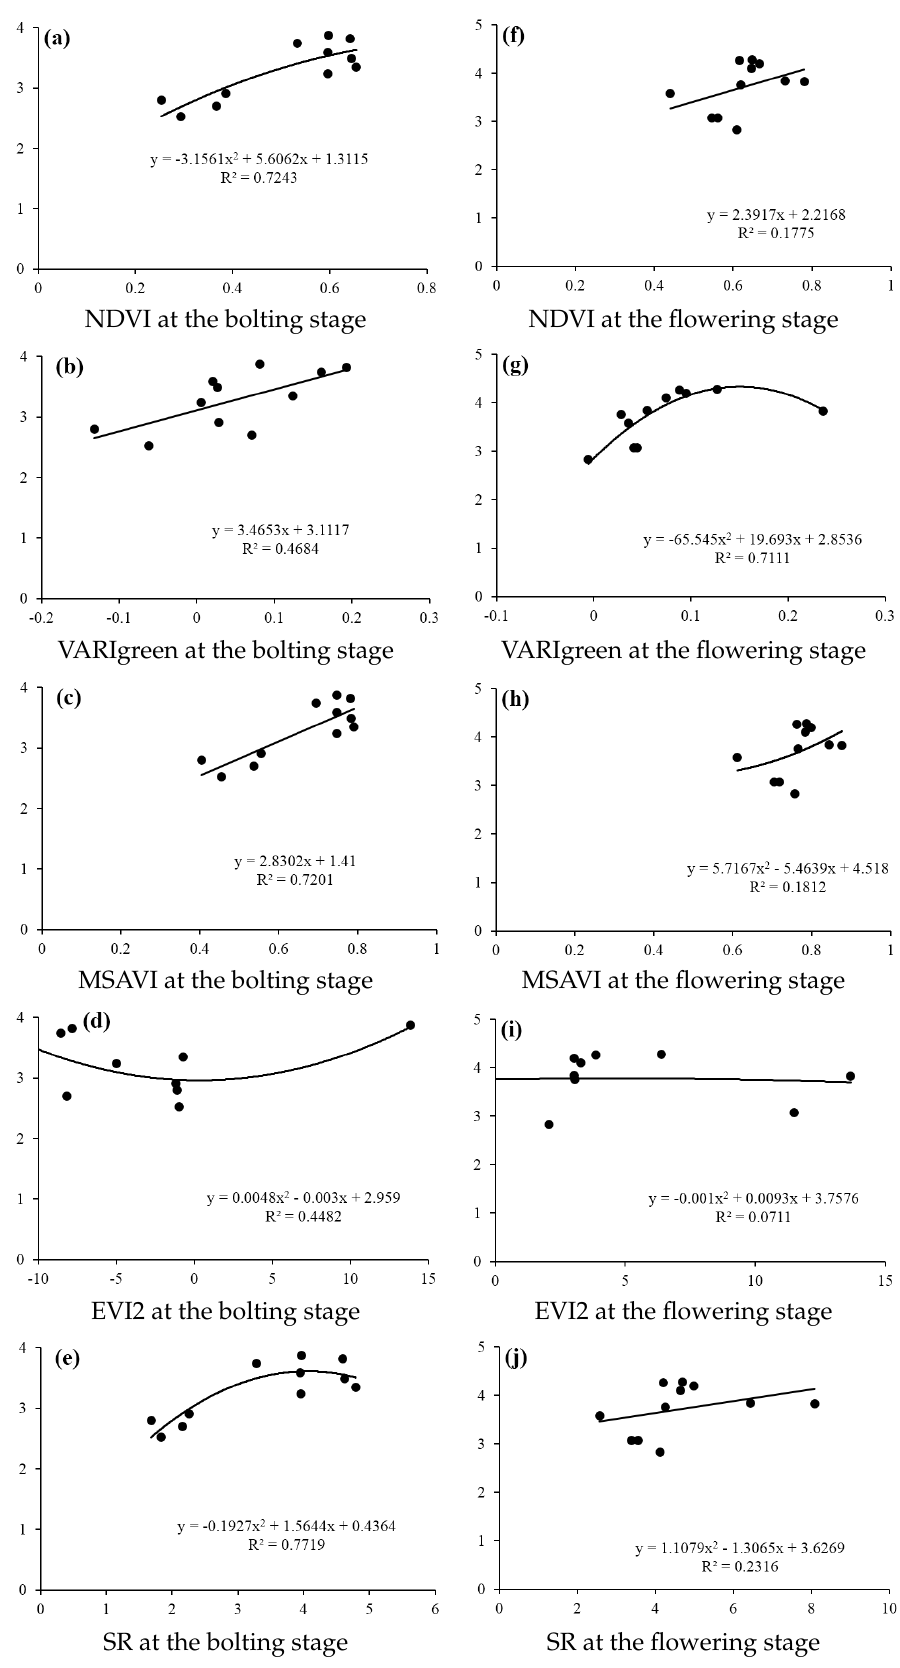
Figure 5. Relationship between ground LAI and vegetable indices from Gaofen-1